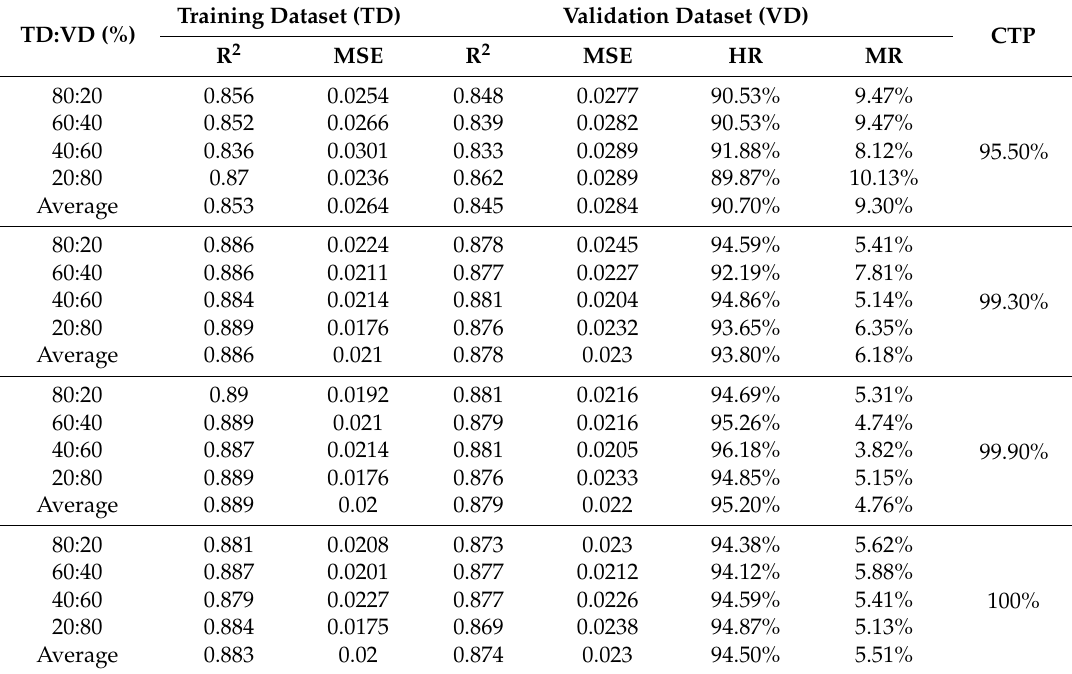
Table 3. Summary of the best-trained networks, R 2 , Mean Square Error (MSE), Hit Ratio (HR) and Miss Ratio (MR) for various Cumulative Target-component Percentage-influence (CTP).